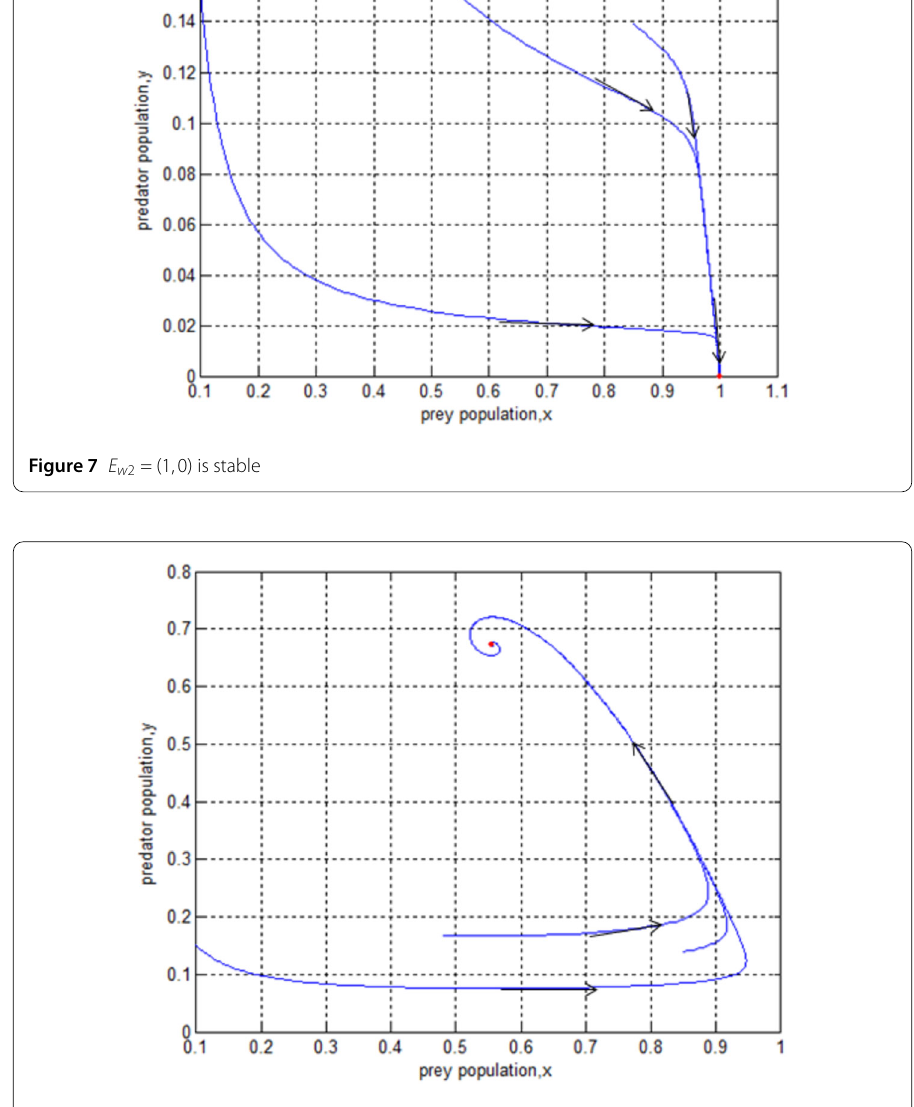
Figure 8 E w ∗ = ( ¯ x ∗ , ¯ y ∗ ) = (0.556,0.671) is